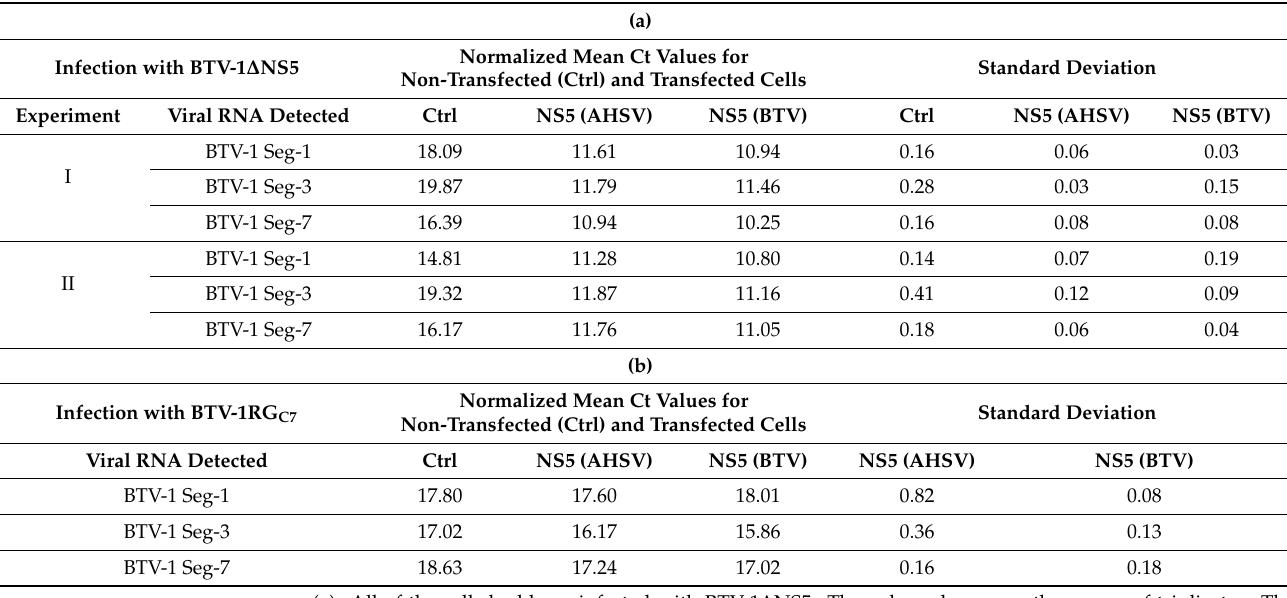
Table 2. Comparisons of real-time PCR Ct values obtained for RNA extracts of pulldown complexes from non-transfected cells and those ectopically expressing NS5-6xHis.